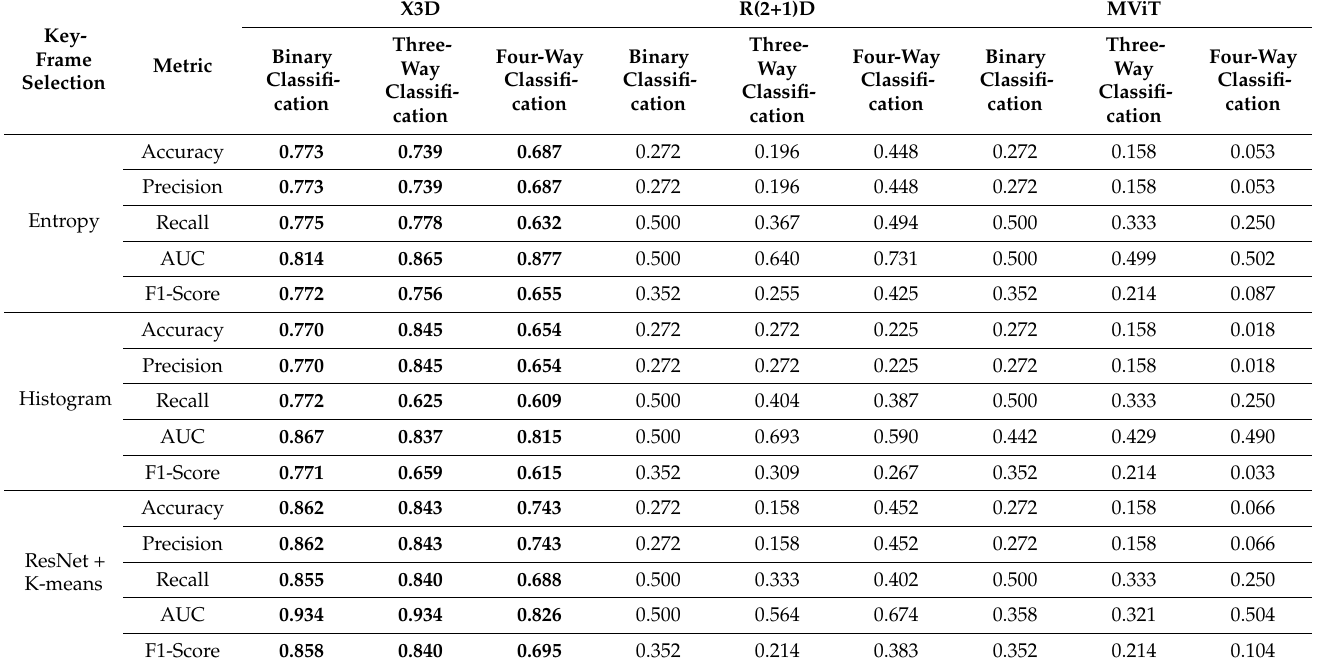
Table 6. Comparison between X3D, R(2+1)D, and MViT. The metrics have been computed as mean values across the classes considered for the classification. The best results are highlighted in bold.